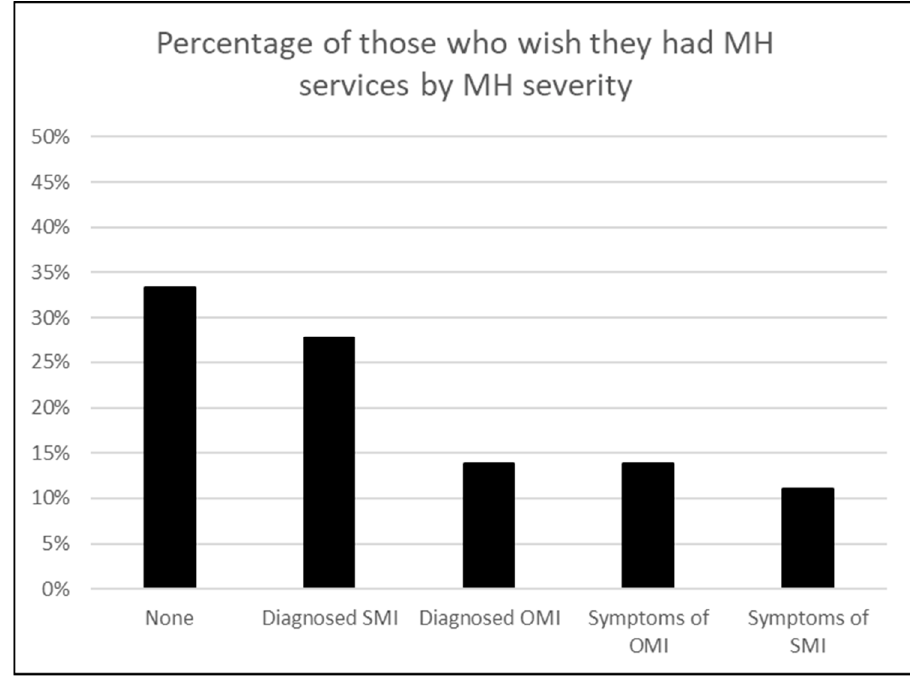
Figure 2. By Authors.